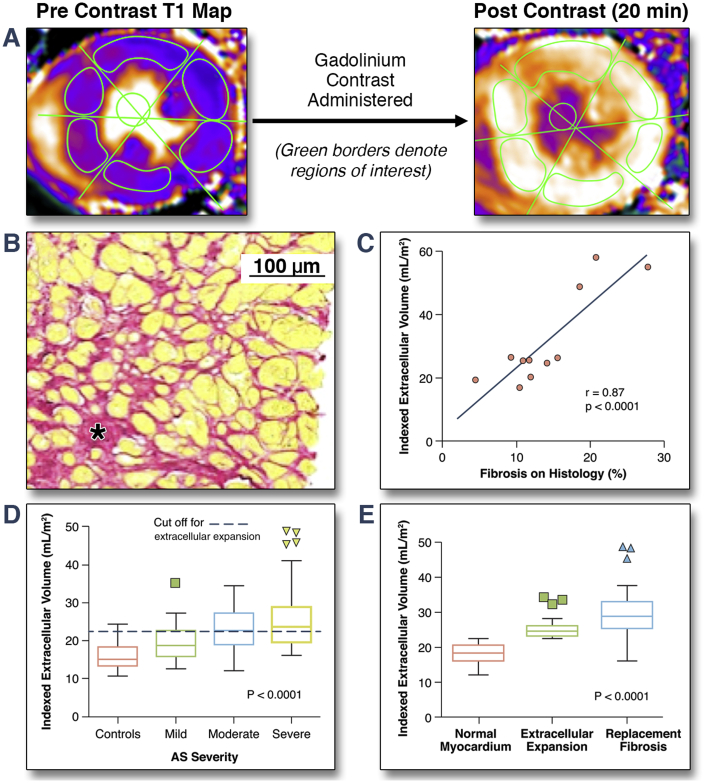
iECV as a Marker of Extracellular Expansion in the Myocardium(A) Regions of interest manually drawn onto native and post-contrast T1 maps are used to calculate indexed extracellular volume (iECV). (B) Histology from a patient with aortic stenosis (AS) with areas of diffuse fibrosis stained with picrosirus red. (C) Excellent correlation between iECV and diffuse myocardial fibrosis on histology. (D) iECV provided good discrimination between disease states. (E) iECV values were higher in patients with replacement fibrosis than patients with normal myocardium or extracellular expansion.